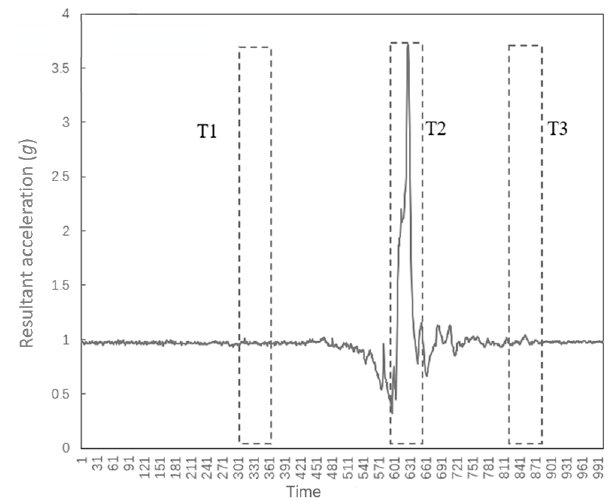
Figure 4. position of the window. Figure 4. Position of the